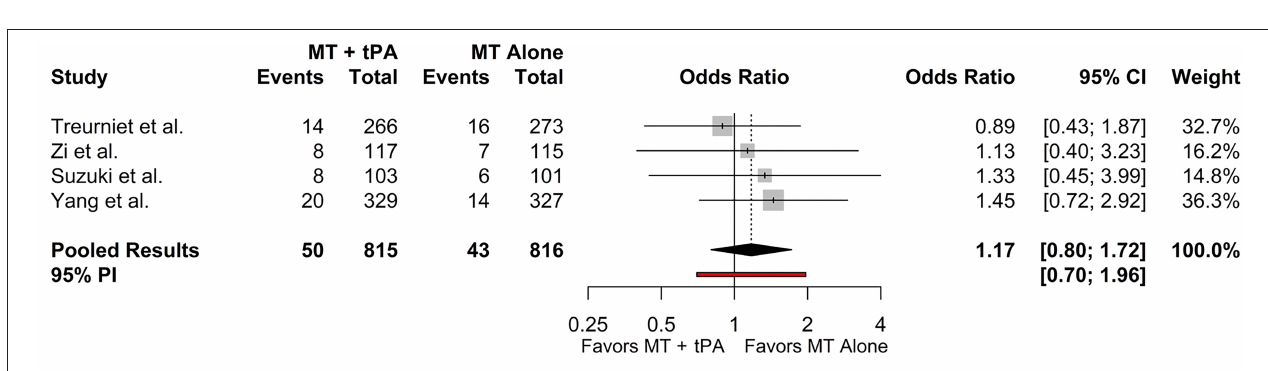
FIGURE 4 | Forest plot of comparisons of mortality at 90 days. Pooled results were computed via the Mantel-Haenszel method, using restricted effects maximum likelihood for estimation of the between-study variance component and Hartung-Knapp adjustment to calculate a 95% confidence interval (CI) around the pooled effect size. A 95% prediction interval (PI) for the pooled results are also displayed as a red bar.